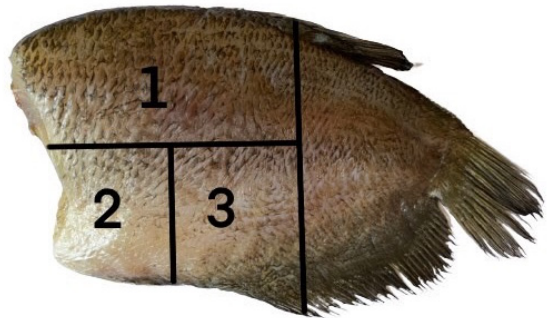
Figure 1. Diagram of the semi-dried Gourami fish used for physicochemical analysis. Each number indicates the part of the fillet used for the different analyses: ( 1 ) texture and color; ( 2 ) moisture, protein, lipid content, TBARS, and pH; and ( 3 ) drip loss, cooking loss, and cooking yield (Modification from Hernández et al. (2009) [18]).